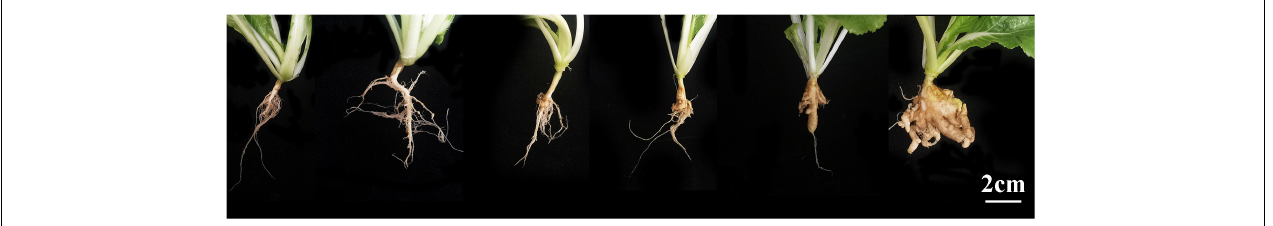
FIGURE 1 | Illustration of the clubroot severity rating scale. From left to right are 0, 1, 3, 5, 7, and